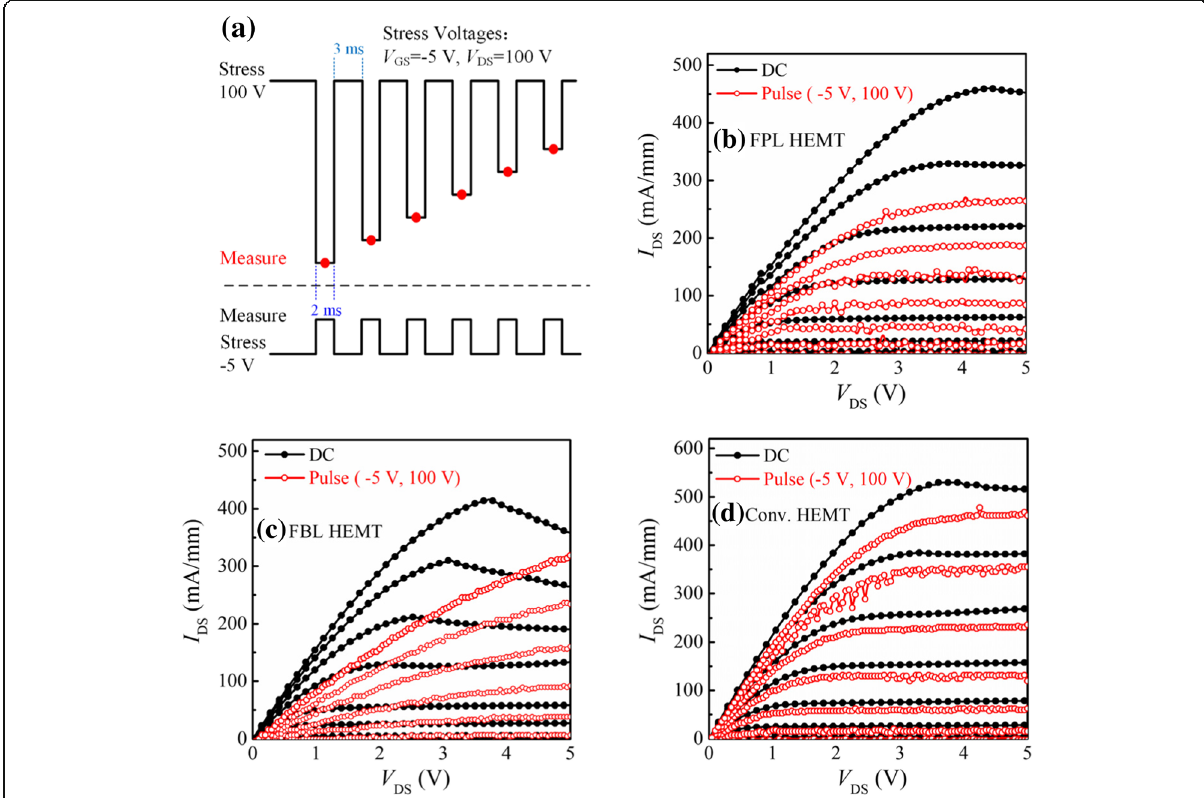
Fig. 5 a Schematic depicting application of stress voltage during the pulsed I DS - V DS measurements. Pulsed I DS - V DS characteristics of the fabricated AlGaN/GaN HEMTs with b FPL HEMT, c FBL HEMT, and d Conv. HEMT ( V GS = − 4~0 V; step: 0.5